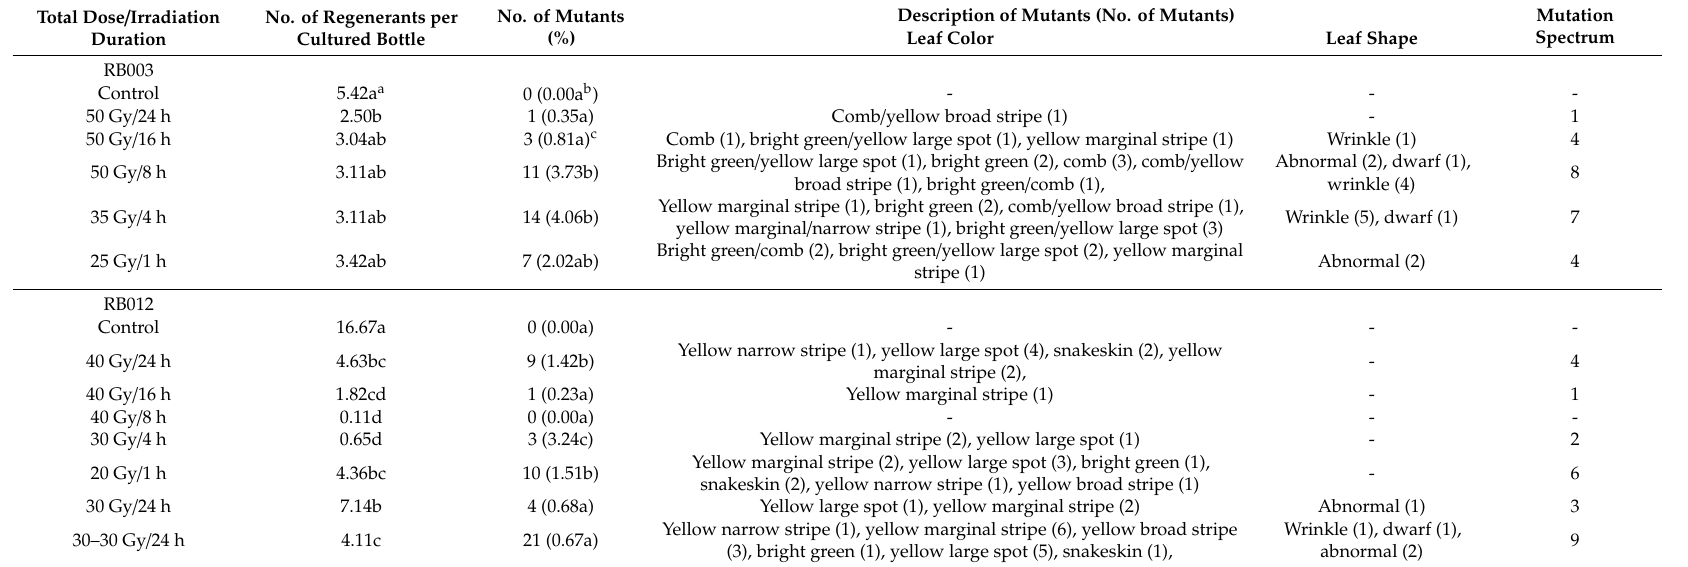
Table 1. Regeneration, mutation frequency, and spectrum of leaf mutants derived from diverse γ -ray treatments in the Cymbidium hybrids RB003 and RB012. Total Dose / Irradiation